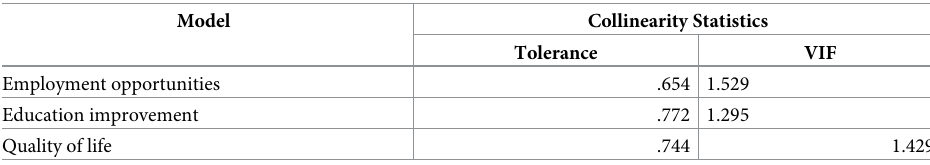
Table 5. Collinearity